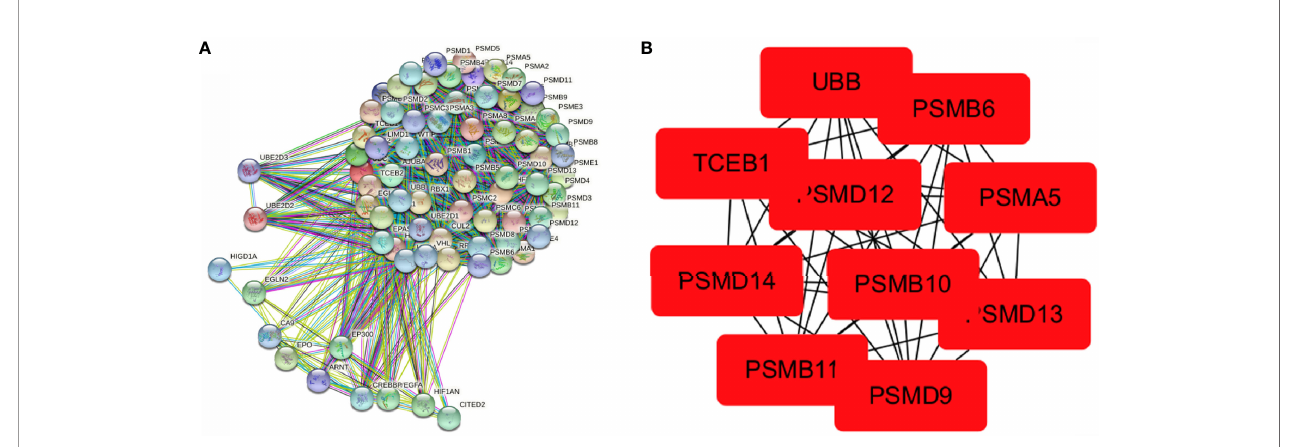
FIGURE 4 | Visualisation of the protein – protein interaction network and Hub genes. (A) PPI network map of 78 hypoxia-associated genes and (B) screening of Hub genes using the